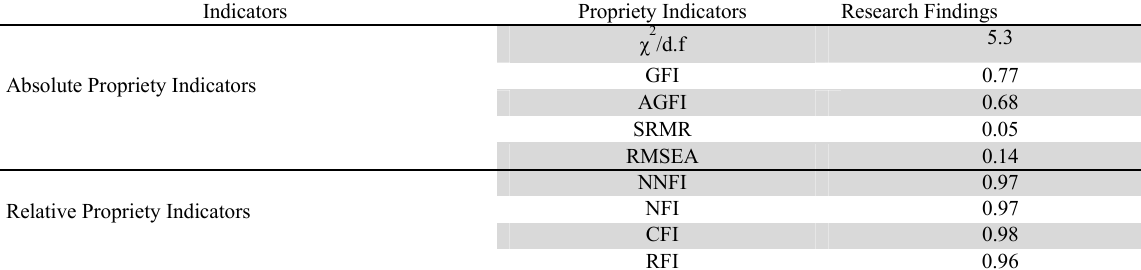
Fit Indices of Structure